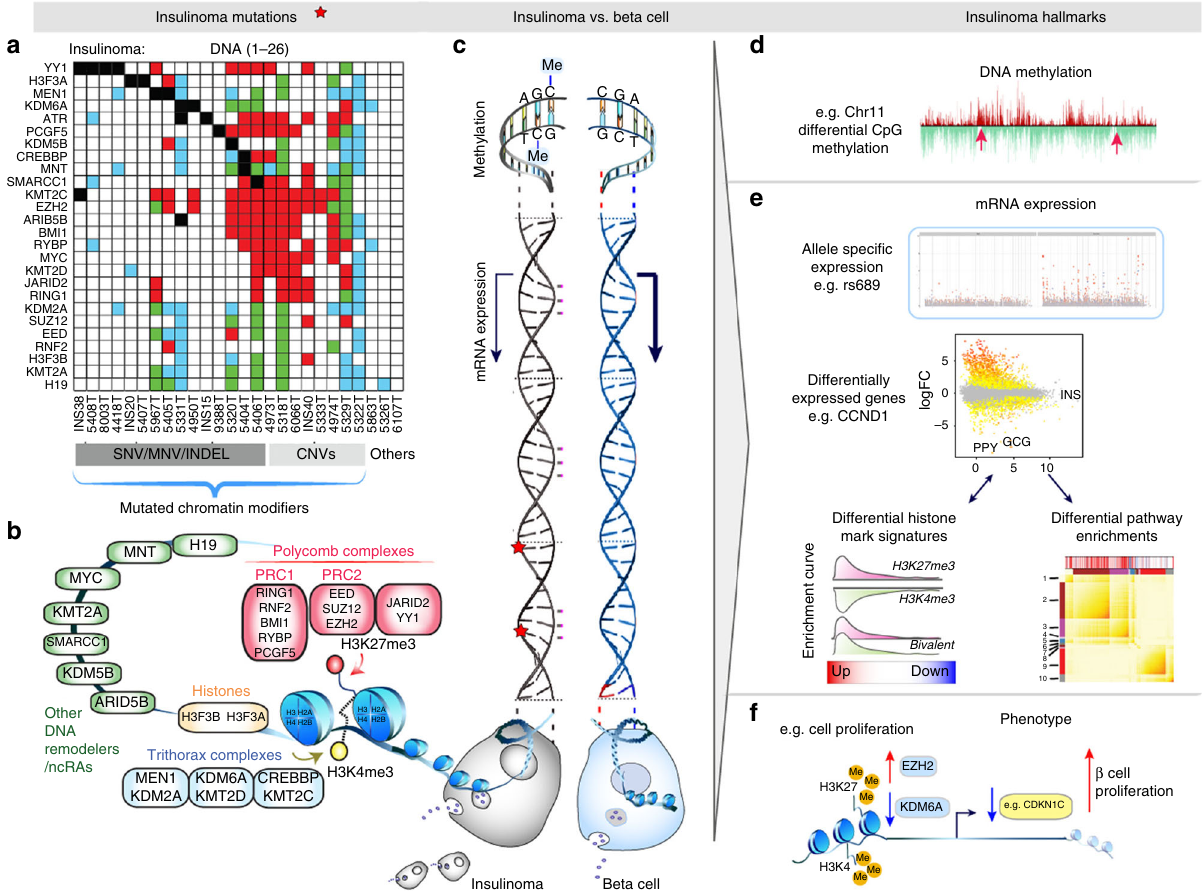
Fig. 6 A schema summarizing the broad heterogeneity of insulinomas and the molecular hallmarks that distinguish insulinoma from beta cells. a A waterfall plot summarizing cumulative coding mis-sense variants ( black ), CNV loss ( blue ), copy-neutral LOH ( green ), or copy number gain ( red ) among polycomb, trithorax and related chromatin-modifying genes. In the grid boxes , each vertical column represents the DNA landscape of each of the 26 insulinomas. Collectively, these observations highlight the frequency of multiple genomic and transcriptomic abnormalities in polycomb, trithorax, and other epigenetic modifying genes across the majority of human insulinomas, the marked heterogeneity among insulinomas, the frequent mutation of multiple chromatin modi fi ers in almost all insulinomas, all despite having selected insulinomas independent of known MEN1 kindreds. b A cartoon emphasizing the relationship between polycomb, trithorax genes, and H3K27me3 and H3K4me3 marks in human beta cells and insulinomas. c An extension of b highlighting mutations ( red stars ), and abnormal CpG methylation. Subsequent panels highlight altered DNA methylation/imprinting abnormalities ( d ), asymmetrical gene expression from imprinted loci and abnormal chromatin marking patterns ( e ), all of which may lead to differential expression pattern of cell cycle genes such as CDKN1C ( f ), all of which may lead to increased beta cell proliferation in The EZH2-CCND1 combination yielded the highest Ki67 labeling indices of all. As expected, overexpression of CCND1 also induced Ki67 labeling in alpha, delta and PP cells in dispersed islets (Supplementary Fig. 5). The other combinations had no effect on delta or PP cells, whereas EZH2 overexpression in combination with silencing CDKN1C did low level induce Ki67 labeling in alpha cells.